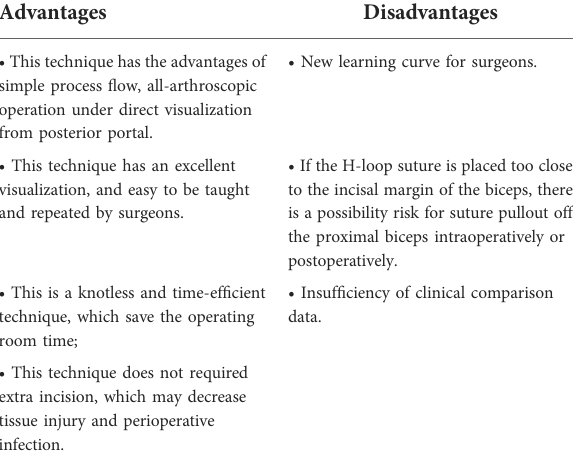
TABLE 2 Advantages and disadvantages of H-loop tenodesis of LHB. Advantages